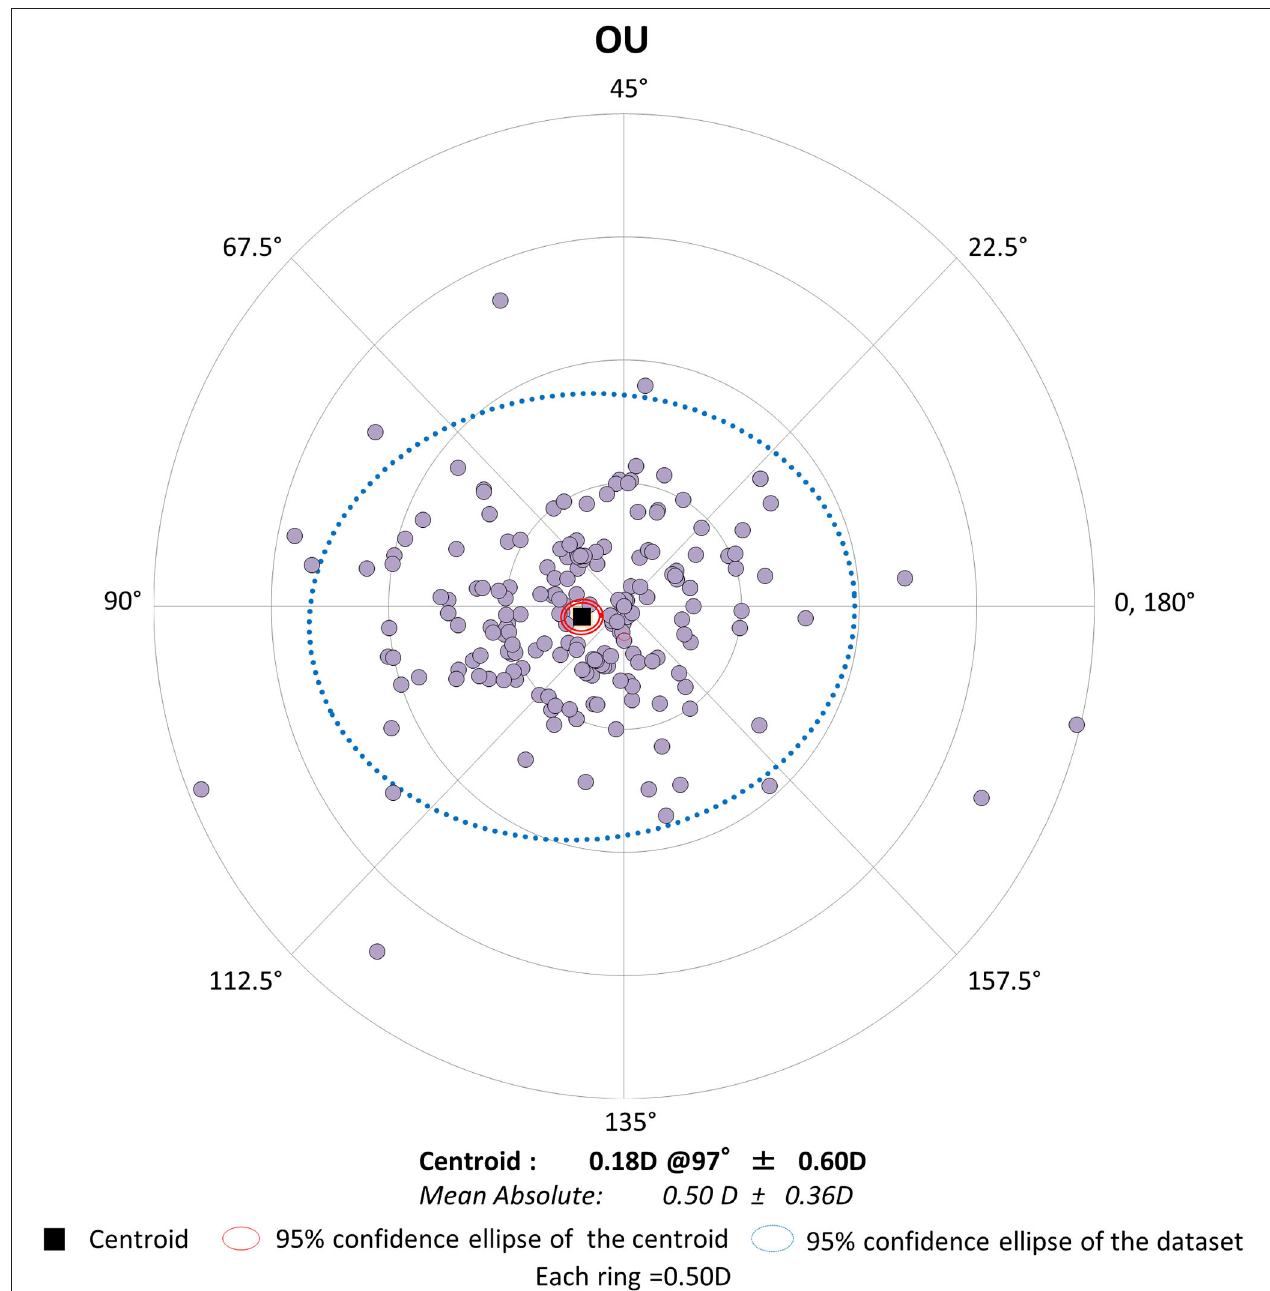
FIGURE 2 | Graph showing the double angle plots of the individual surgically induced astigmatism using bilateral data.